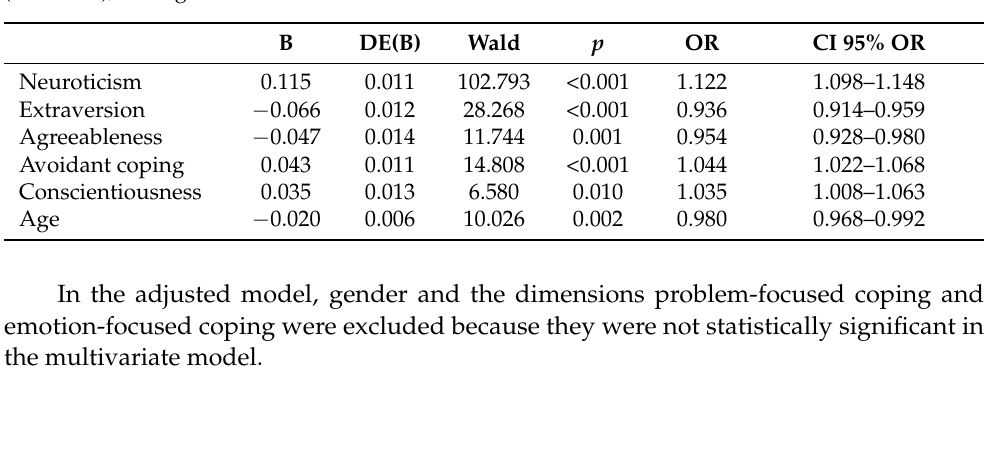
Table 6. Logistic regression model adjusted to estimate whether burnout was present or not. Indi- cators: personality variables except openness to experience (NEO-FFI), coping strategy variables (COPE-28), and